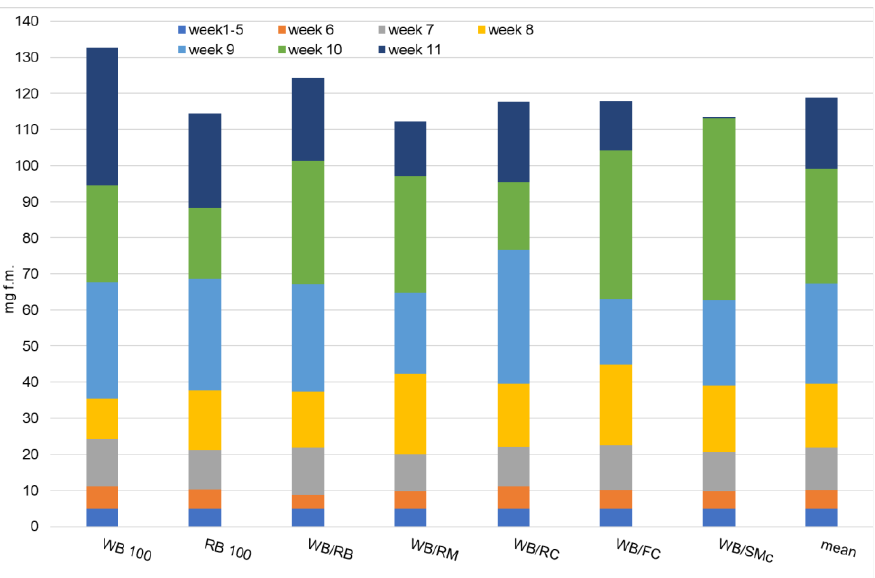
Figure 3. Individual larval weight gain and the final weight (on wet weight basis) of yellow meal- worm larvae depending on the experimental diet; WB (wheat bran), RB (rye bran), WB/RB (wheat bran/rye bran), WB/RM (wheat bran/rapeseed meal), WB/RC (wheat bran/rapeseed cake), WB/FC (wheat bran/flax cake), WB/SMc (wheat bran/ Silybum marianum